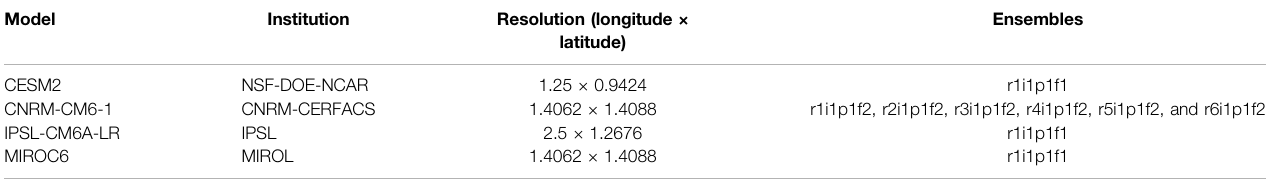
TABLE 1 | Basic information of four global climate models in CMIP6.